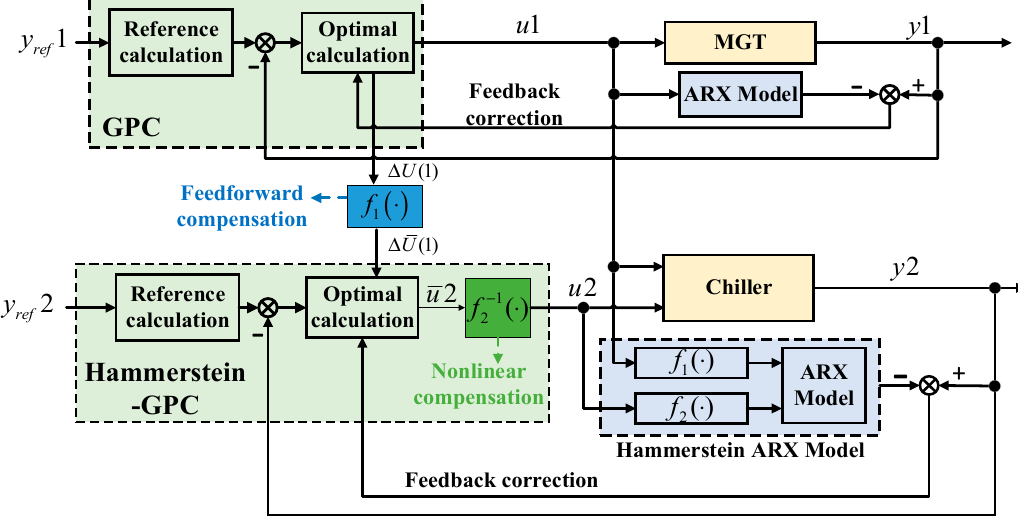
Figure 5. Coordinated predictive control strategy for the MGT-CCP system.